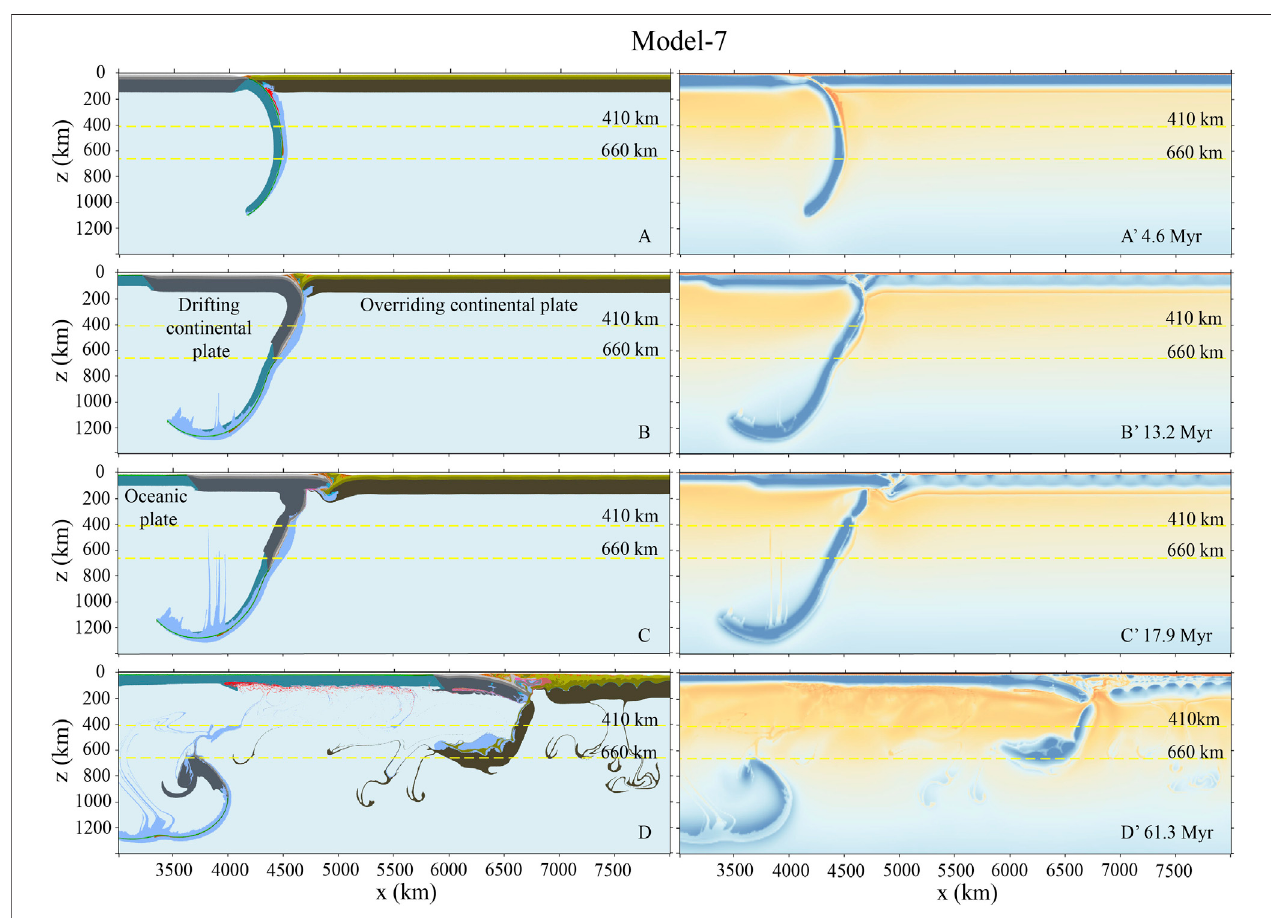
FIGURE 9 | Model-7 evolution with a decreased and uniform plastic friction coef fi cient of the overriding lithospheric mantle of λ · sin ( φ ) (cid:2) 0.1 ( Supplementary Table S2 and Supplementary Equation S11 in the supporting information). All the other parameters are identical to Model-6 ( Figure 8 ). (A – D) The composition fi eld evolution with the corresponding colorbar shown in Figure 2A . (A ’ – D ’ ) The effective viscosity evolution with the corresponding colorbar is shown in Figure 2B .